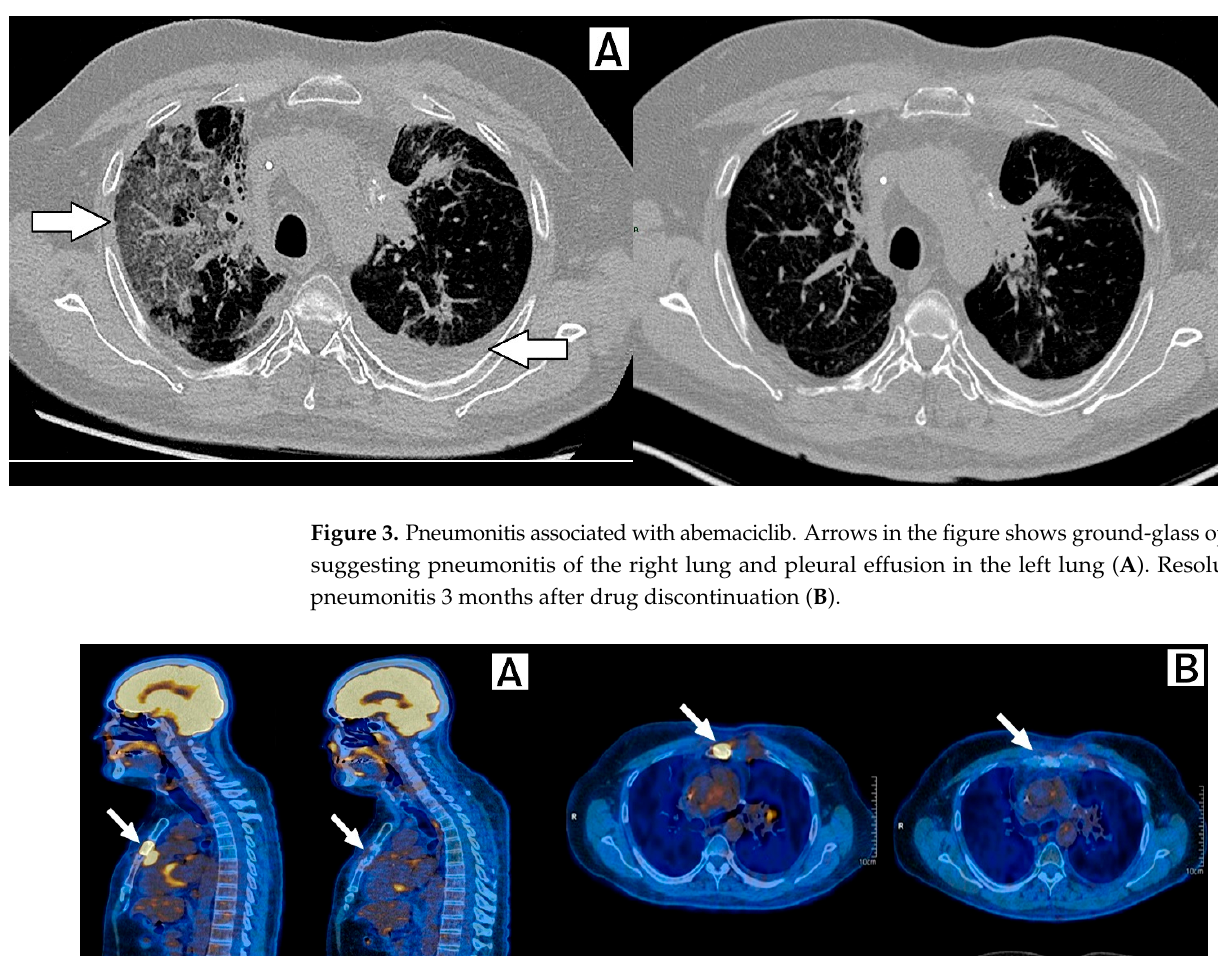
Figure 3. Pneumonitis associated with abemaciclib. Arrows in the figure shows ground-glass opac- ities, suggesting pneumonitis of the right lung and pleural effusion in the left lung ( A ). Resolution of pneumonitis 3 months after drug discontinuation ( B ).